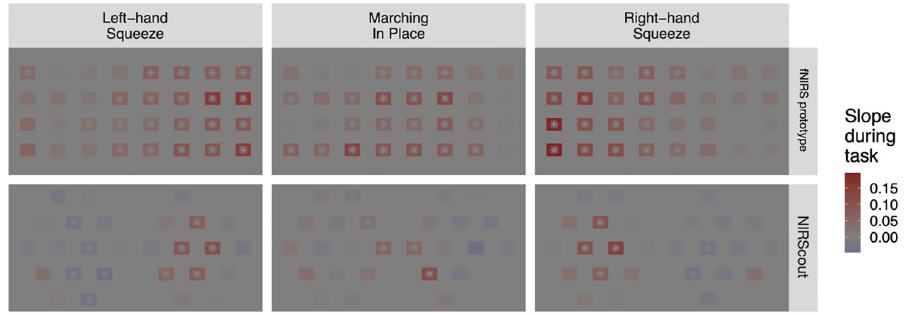
Fig 3. Mean Δ HbO during each motor task for each fNIRS system. Topographic maps of group mean slope (in units of mMol/mm 3 ) during task. Colors indicate posterior median; locations with posterior distributions in which zero falls outside the 95% credible interval are marked with an